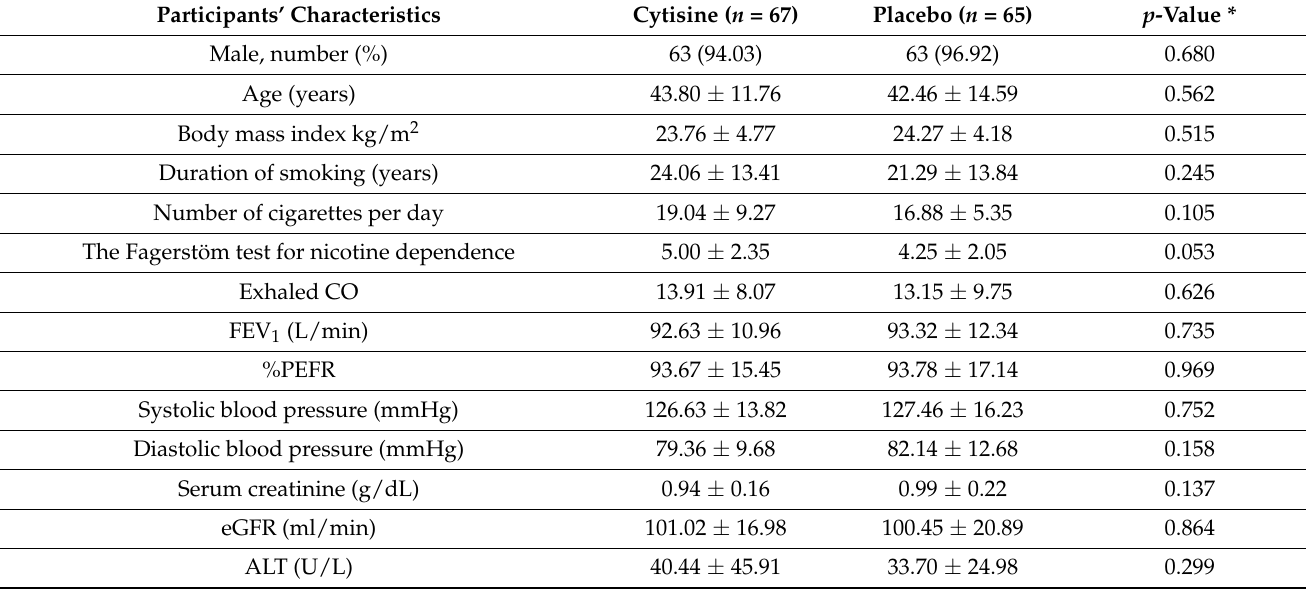
Table 1. Participants’ characteristics.